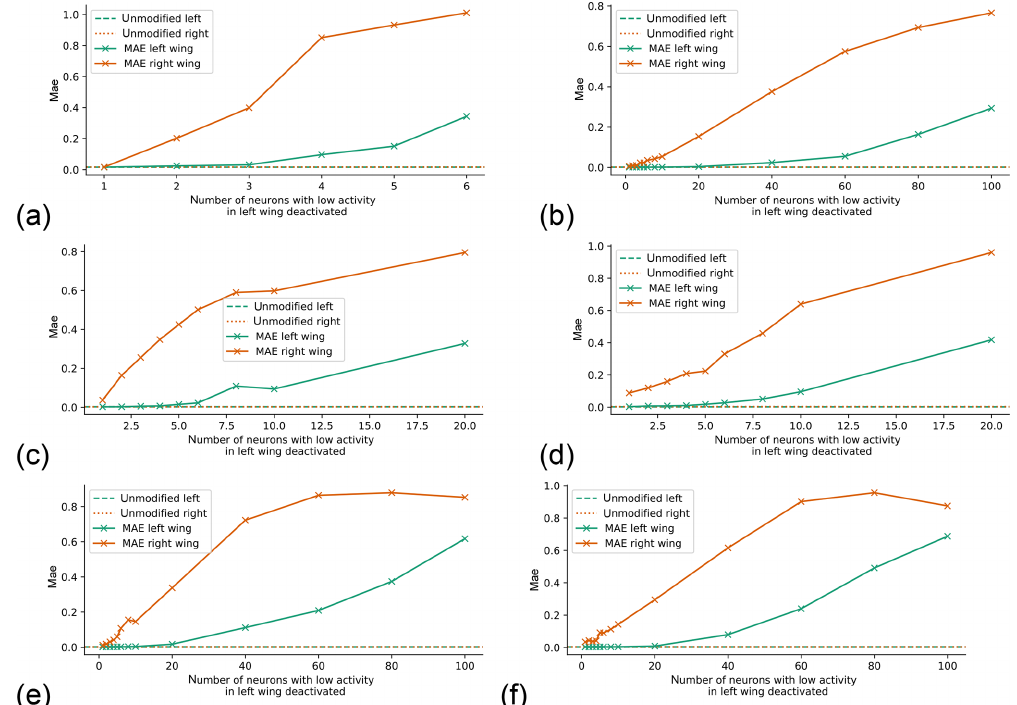
Figure 4. As Fig. 3e but for different neural network architectures. (a) Shallow and narrow (1 hidden layer with 8 neurons); (b) shallow and wide (1 hidden layer with 128 neurons); (c) intermediate (2 hidden layers with 32 neurons each); (d) deeper intermediate (4 hidden layers with 32 neurons each); (e) deep and wide (4 layers with 128 neurons each); (f) very deep and wide (8 layers with 128 neurons